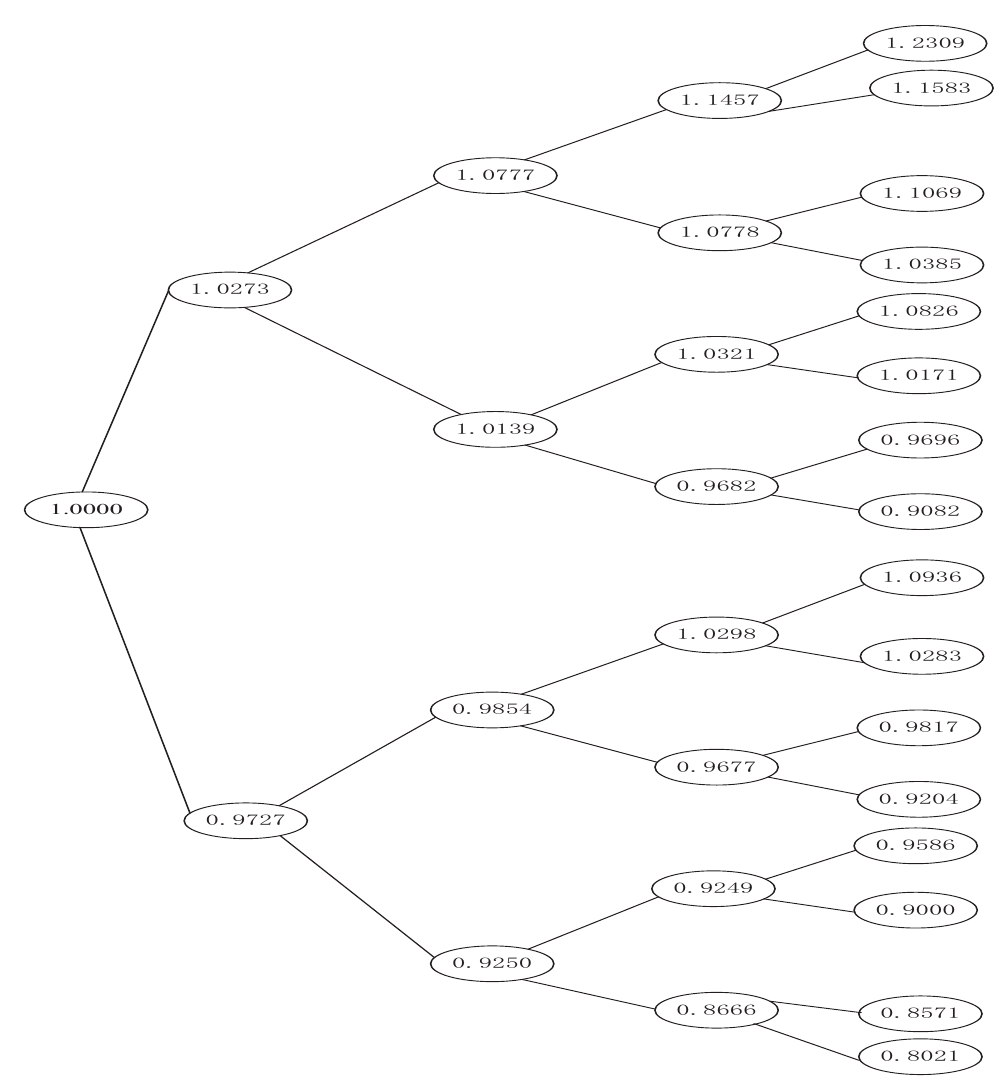
Figure 3. A four-step Hermite binomial tree with arbitrage, H = 0.75 and k =